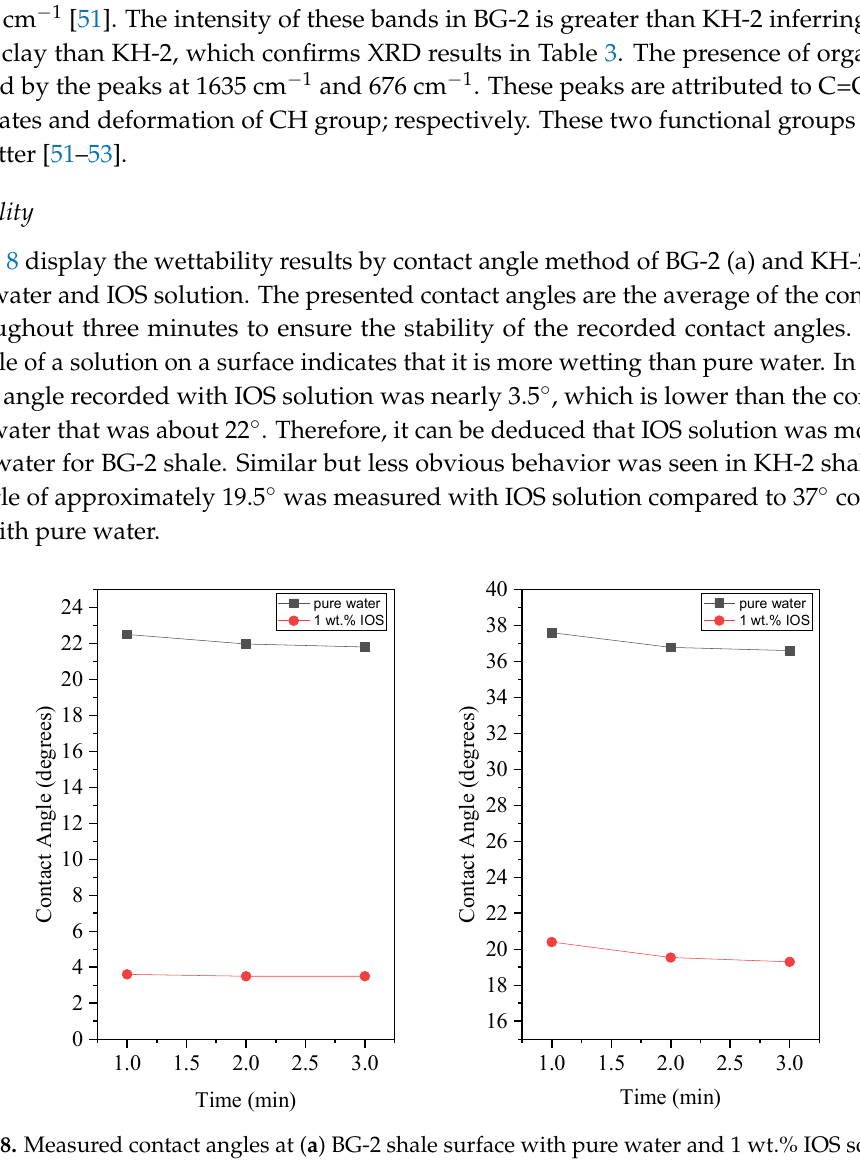
Figure 7. Fourier-Transform Infrared Spectroscopy (FTIR) Spectrum of BG-2 and KH-2 shales.